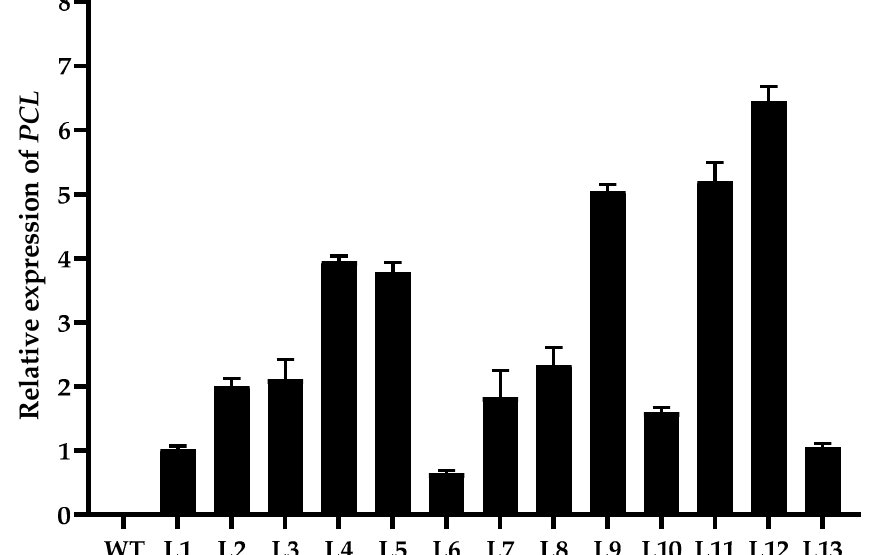
Figure 1. PCL transcript levels between different lines. WT: wild-type. L1–L13: PCL transgenic lines of Nicotiana nudicaulis .